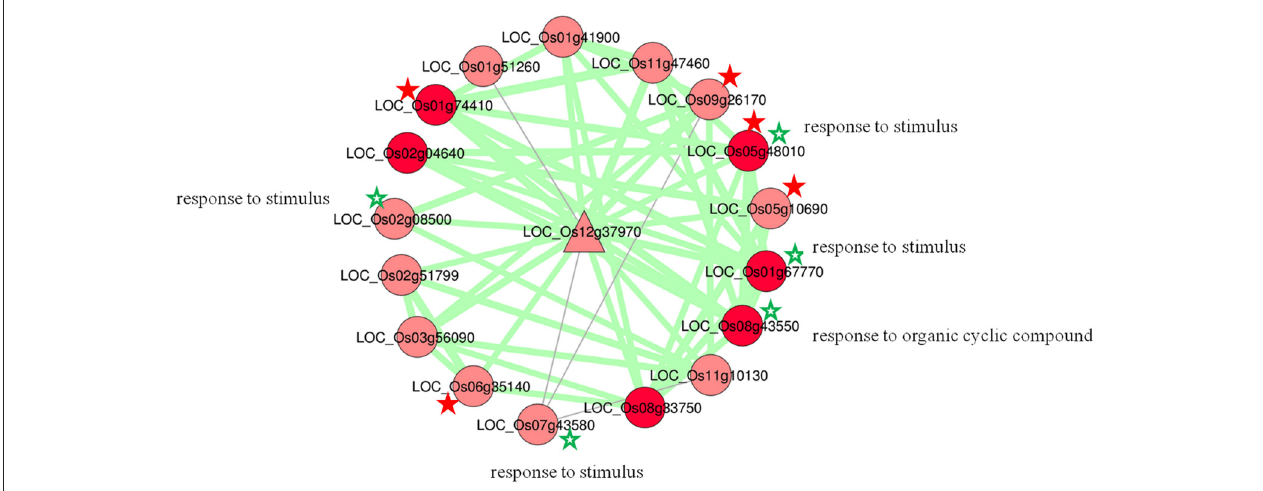
FIGURE 4 | Hub OsMYB LOC_Os12g37970 with the highest connection in co-regulatory network. Differentially expressed nodes are in dark red color. Genes with abiotic stress related GO term are marked with green star ( * ). Characterized genes having role in abiotic stress response are highlighted with red star ( *